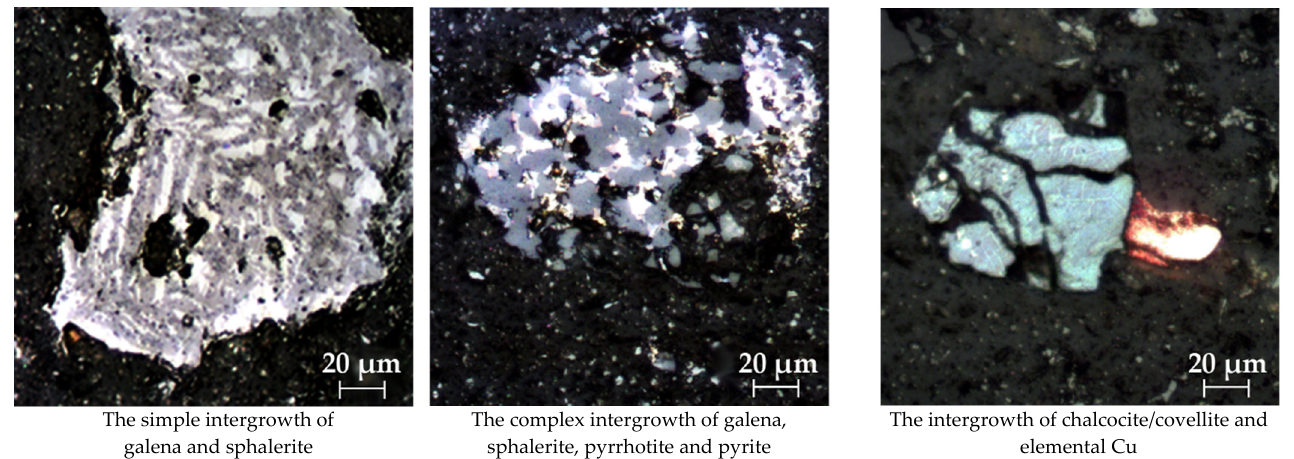
Figure 17. Optical microscopy of sulfidized jarosite-PbAg sludge with the addition of sulfur. According to the optical microscopy study of sulfidized jarosite-PbAg sludge, with the addition of sulfur and carbon (sample no 10-83/13_S/4_C) mineral grains of galena, sphalerite, elemental iron and copper, spinel phases, hematite, and magnetite were determined (Figure 18). Galena was mostly in liberated form, ranging from 10 to more than 70 µm. It is characteristic that it contains tendril of sphalerite and elemental Fe. Elemental Fe occurs in samples in the form of liberated grains bigger than 20 µm, but also in the form of microinclusions in galena. Sphalerite is less abundant, appearing in a form of liberated grains, inclusions, and simple intergrowths with galena. The size of liberated grains of sphalerites is up to 40 µm.